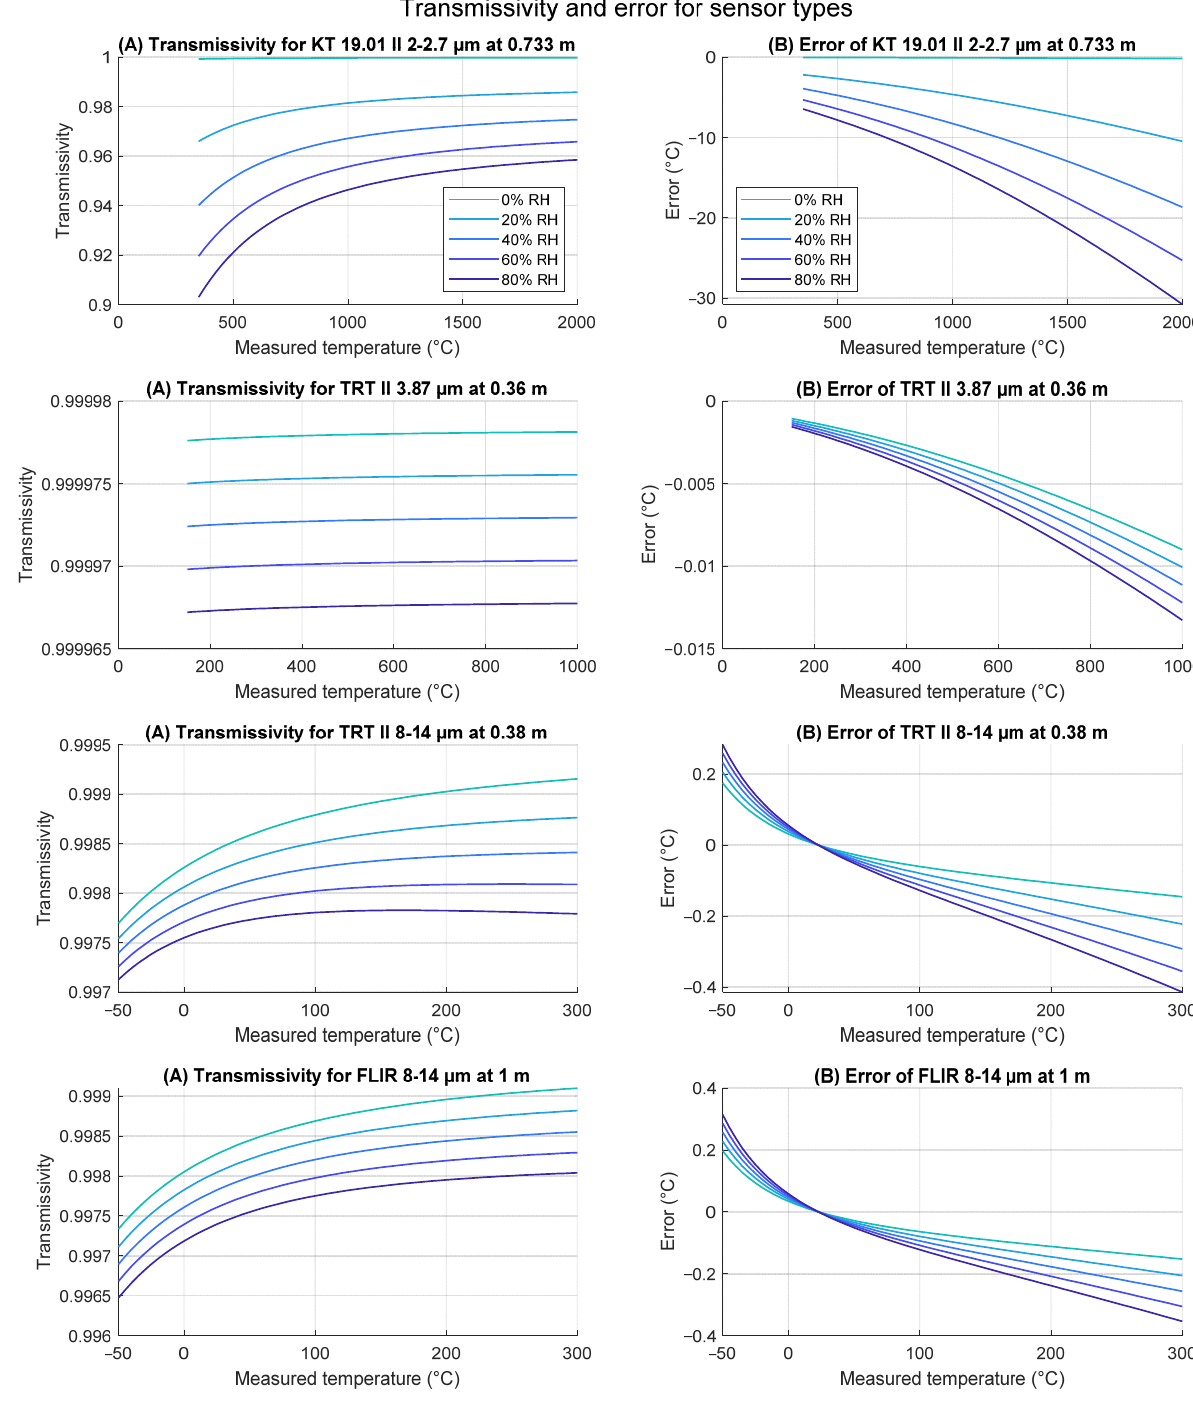
Figure 6. Considering the sensor spectral sensitivity, ( A ) the effective transmissivity is plotted and ( B ) the calculated error of measurement due to the atmospheric transmissivity including radiation contribution at the set focal distance, air pressure 1013.25 hPa, and temperature 296 K for various relative humidity levels is plotted. The focal distance of the thermal imaging camera is adjustable and was set to 1 m.